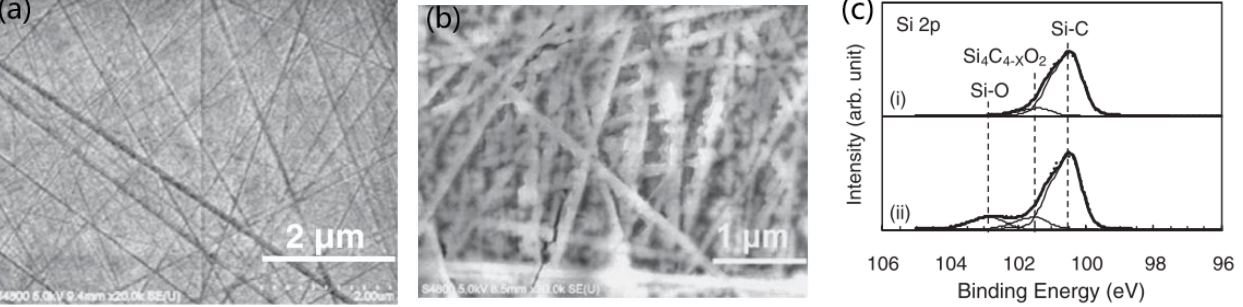
Figure 15. SEM images of SiC surface: ( a ) unprocessed surface and ( b ) processed surface irradiated by water vapor plasma; ( c ) XPS spectra of 4H-SiC Si2p [38].